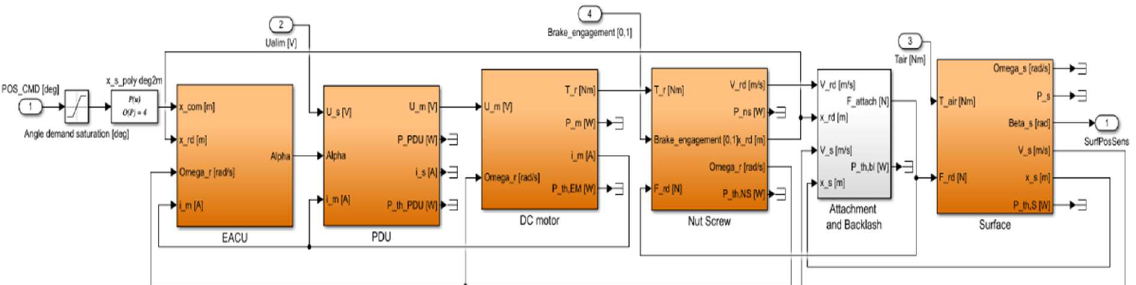
Figure 10. Main screen of the RT model.